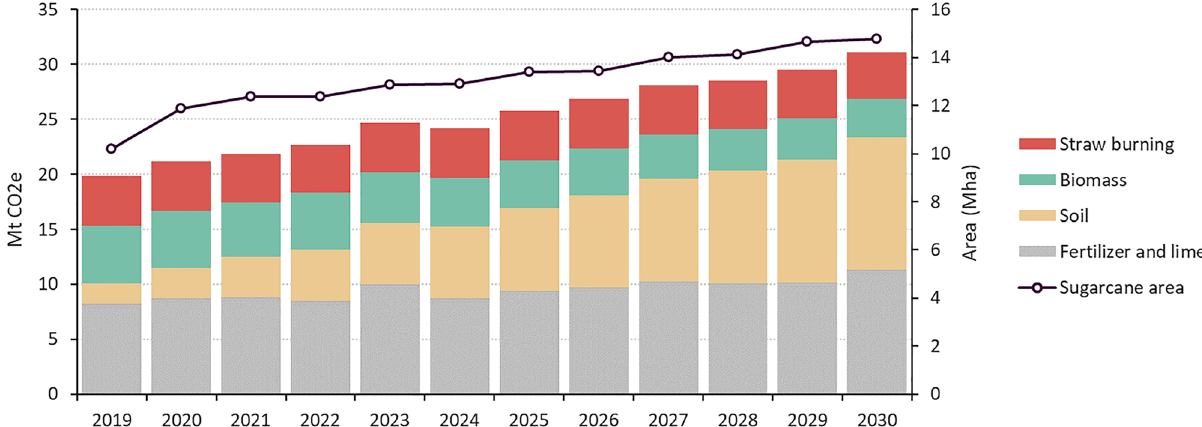
Figure 4. GHG emissions from sugarcane production. LULUCF emissions (from biomass and soil carbon stock changes) represent about 50% of the total, whilst the remaining emissions are due to agricultural practices (fertilizer and lime application and straw